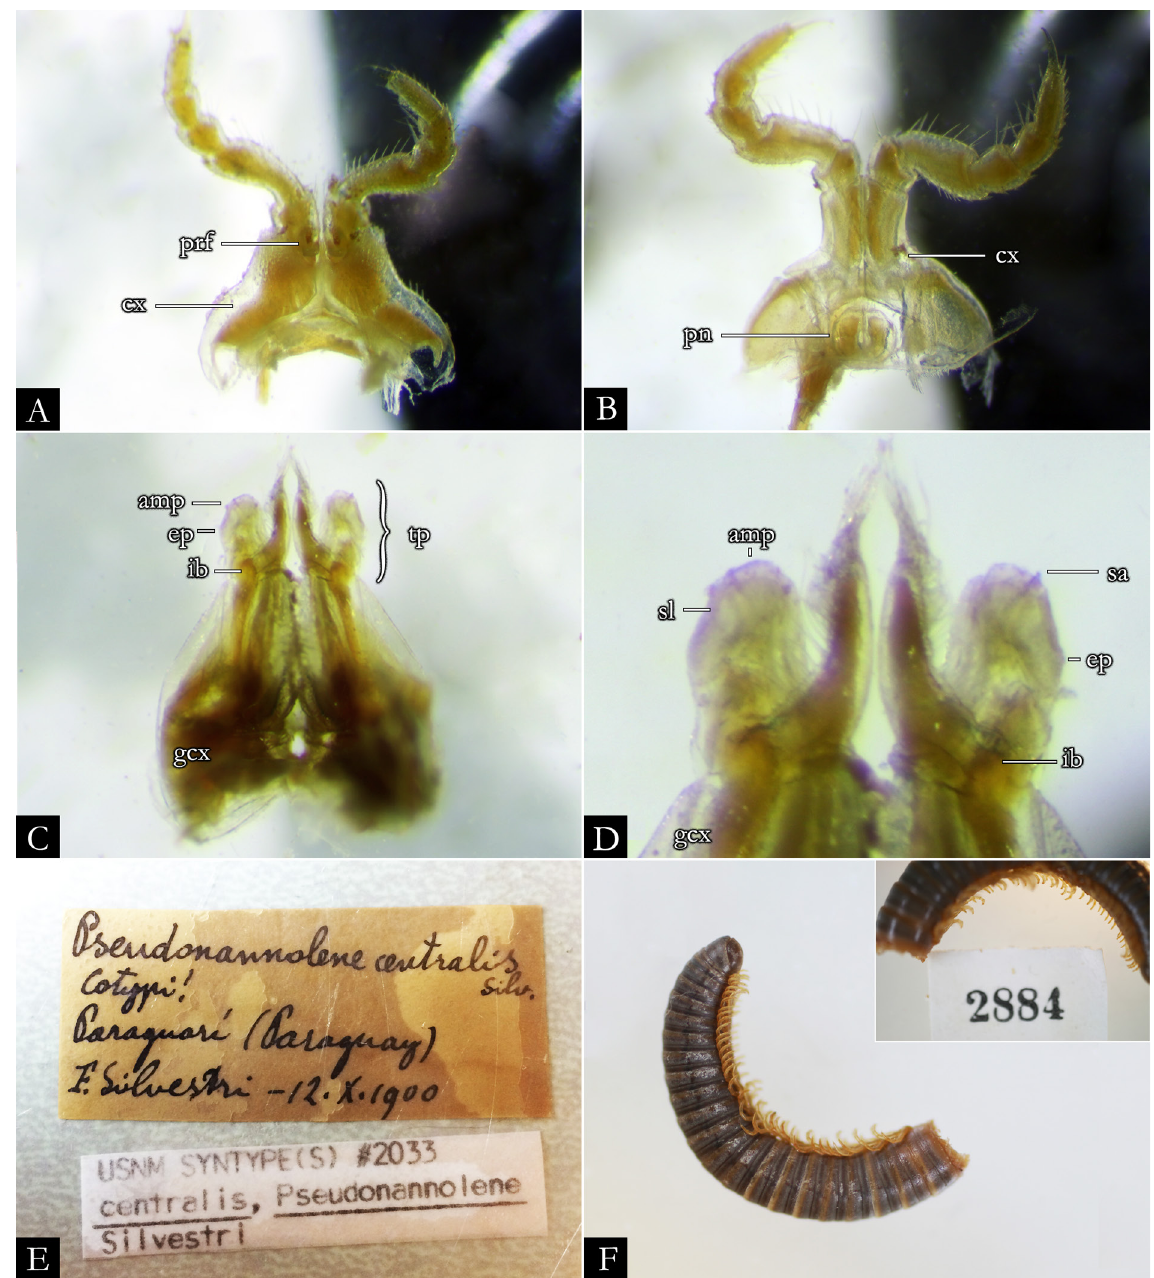
Fig. 63. Pseudonannolene centralis Silvestri, 1902, syntype, ♂ (USNM 2033). A . First leg-pair. B . Second leg-pair. C . Gonopods, in anal view. D . Detail of telopodites, in anal view. E . Original label of type material. F . Body of female syntype, in lateral view (ZMB 2884). Abbreviations: see Material and methods. Images not to